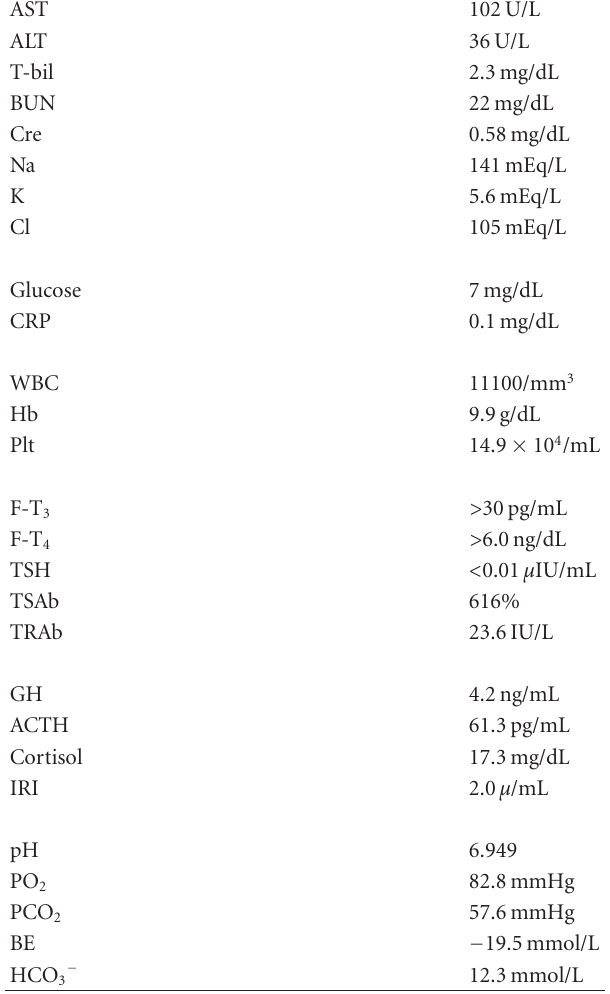
Table 1: Laboratory findings in the intensive care